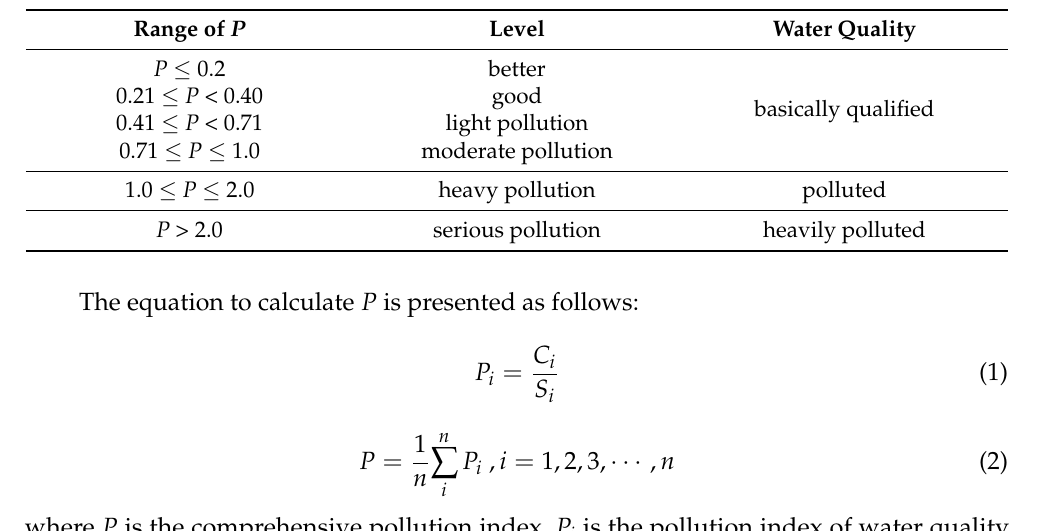
Table 2. Comprehensive pollution index classification